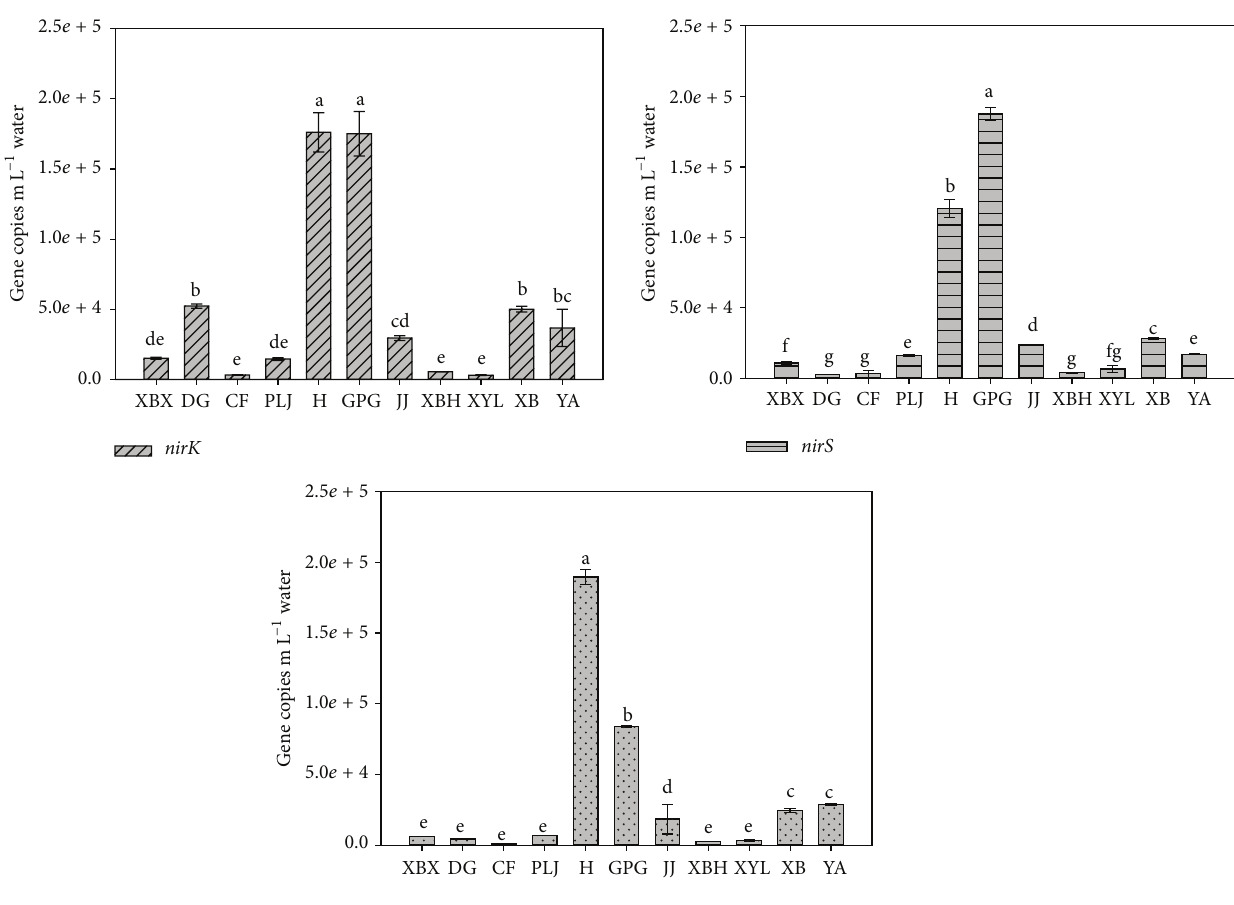
Figure 2: Abundance of nirS, nirK , and nosZ genes in the water samples. Error bars indicate standard deviations ( 𝑛 = 3 ). The different letters indicate significant differences ( 𝑝 < 0.05 ). Stream names: XBX = Xinbaoxiang, H = Haihe, XB = Xiaba, YA = Yaoan, JJ = Jinjia, GPG = Guangpugou, PLJ = Panlongjiang, XBH = Xibahe, CF = Chuangfang, DG = Daguang, and XYL =